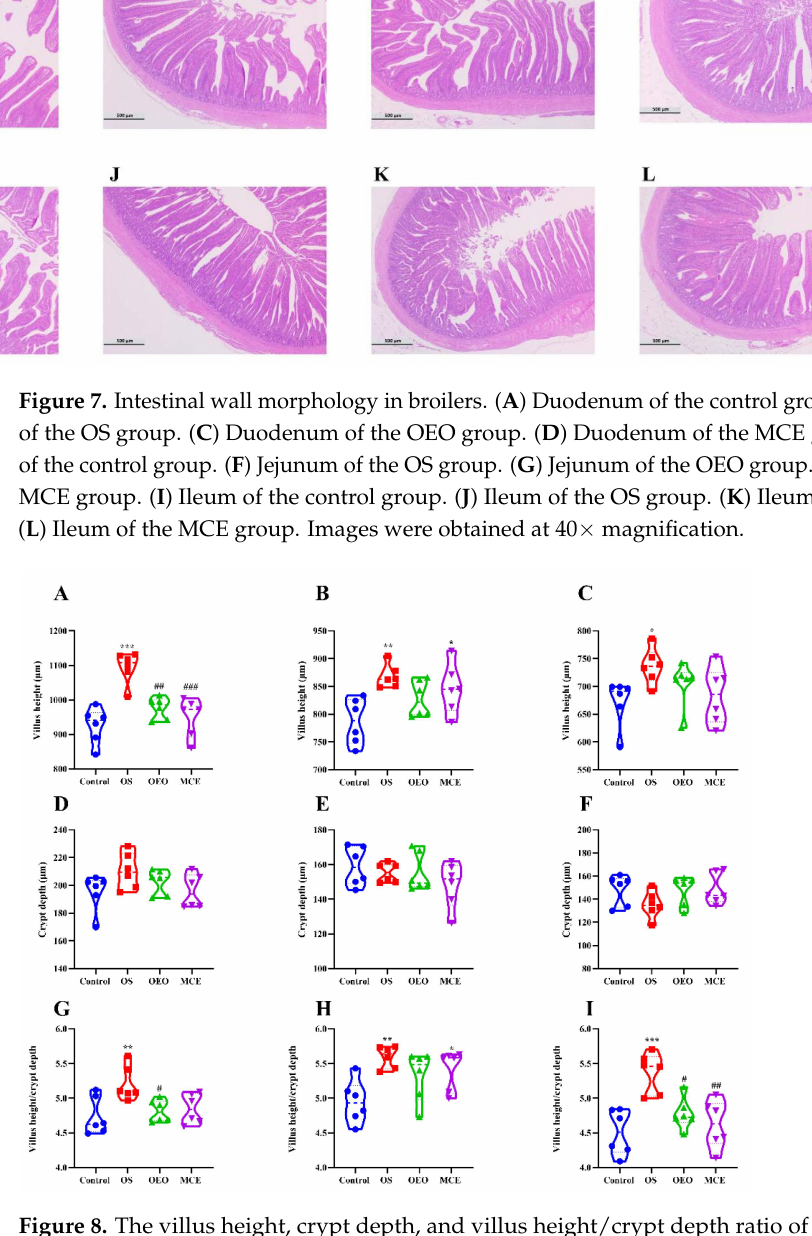
Figure 8. The villus height, crypt depth, and villus height/crypt depth ratio of broilers. ( A ) Villus height of the duodenum. ( B ) Villus height of the jejunum. ( C ) Villus height of the ileum. ( D ) Crypt depth of the duodenum. ( E ) Crypt depth of the jejunum. ( F ) Crypt depth of the ileum. ( G ) Villus height/crypt depth ratio in the duodenum. ( H ) Villus height/crypt depth in the jejunum. ( I ) Villus height/crypt depth in the ileum. * p < 0.05, ** p < 0.01, *** p < 0.001, vs. control group; # p < 0.05, ## p < 0.01, ### p < 0.001, vs. OS group ( n =